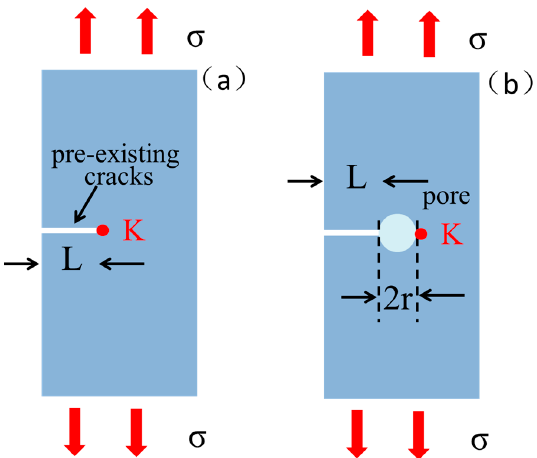
Figure 13. Cracking mechanism in the case of no penetration; ( a ) no pores; ( b ) pores.